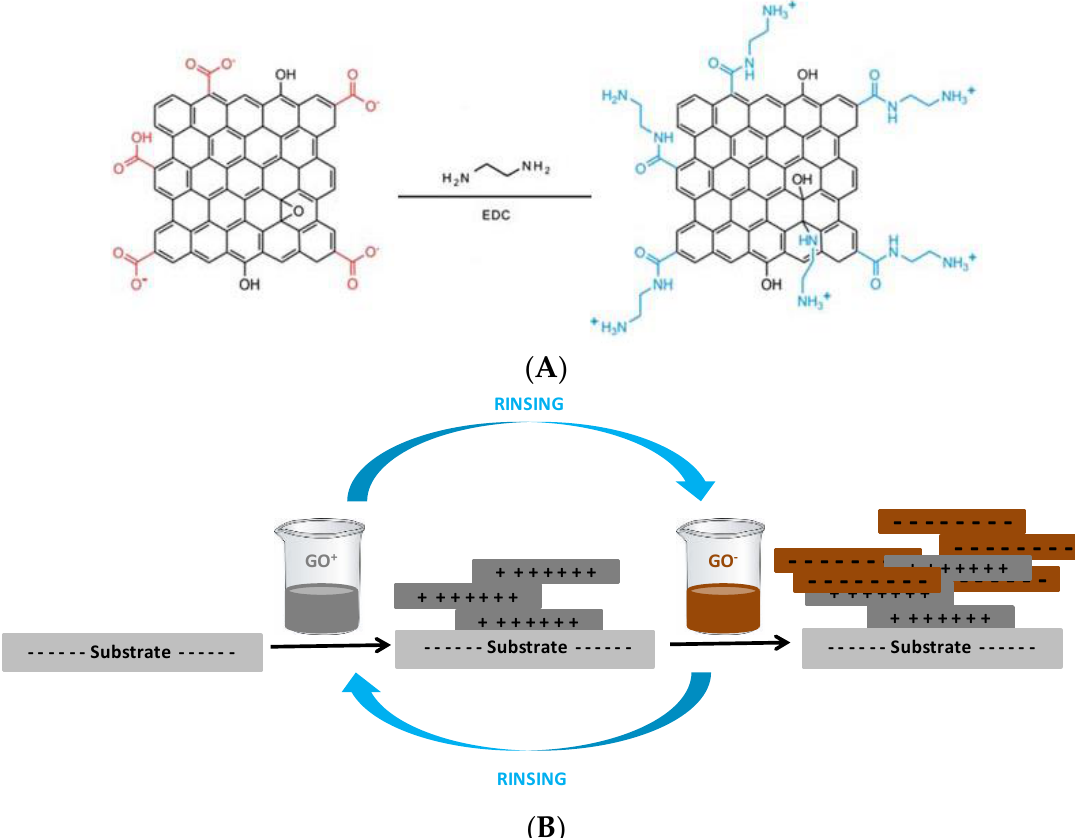
Figure 1. ( A ) Schematics of the chemical modification of GO (redrawn from [50]); ( B ) representation of the LbL assembly of the GO multilayer with GO-COO − and GO-NH 3+ followed by thermal reduction.